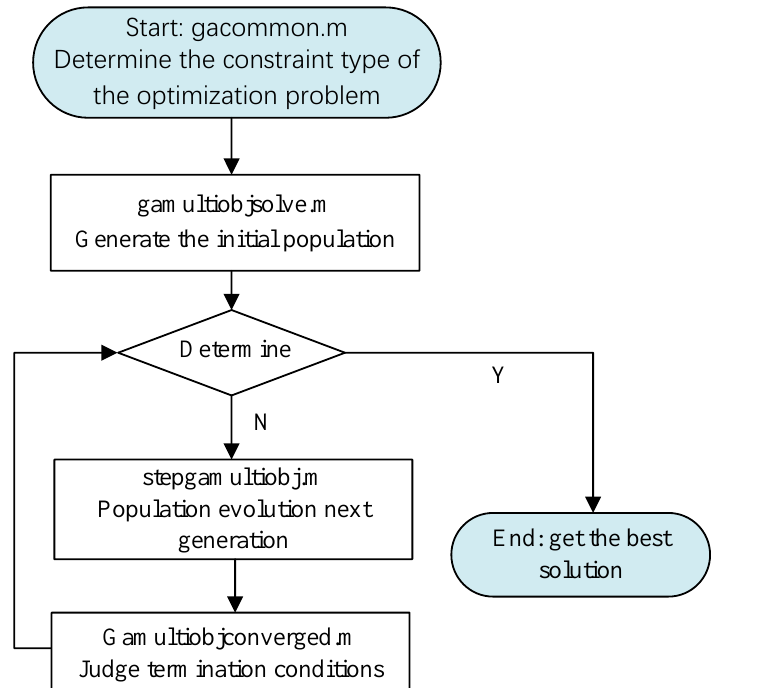
Figure 2. Software implementation of NSGA-II algorithm.